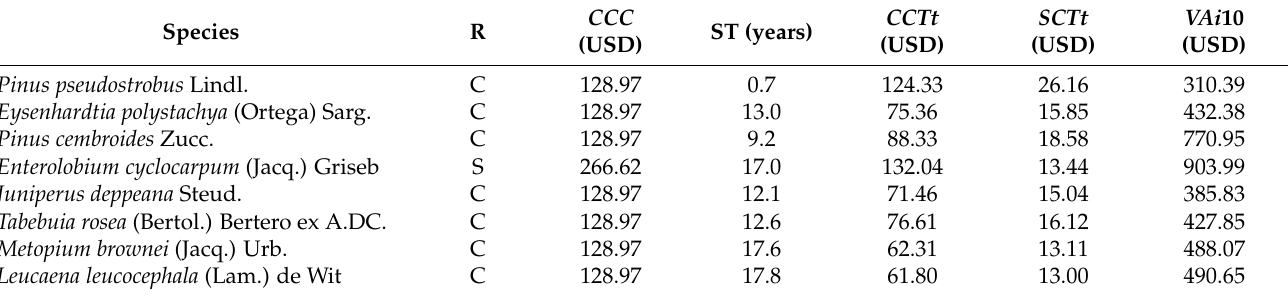
Table 5. Accessions of useful forest species with high importance stored at the